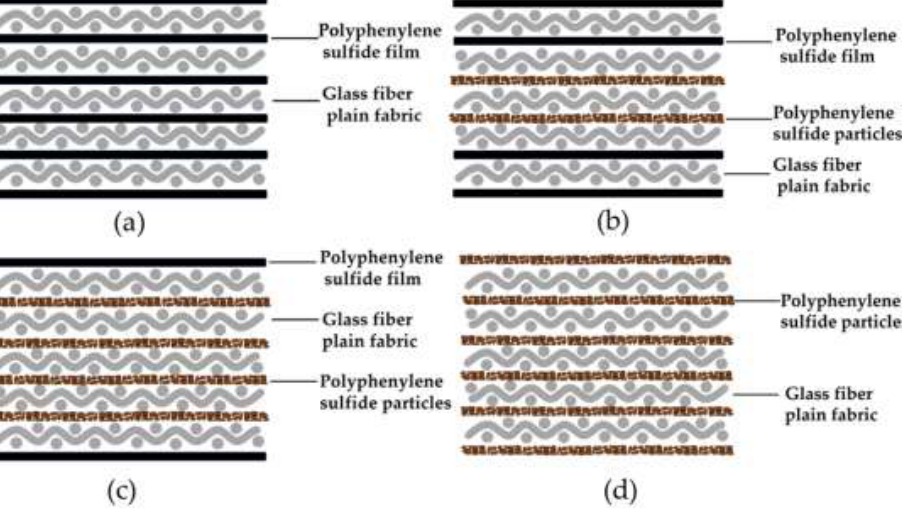
Figure 3. Composite laminate structure diagram. ( a ) P0F6, pure PPS film; ( b ) P2F4, the ratio of film